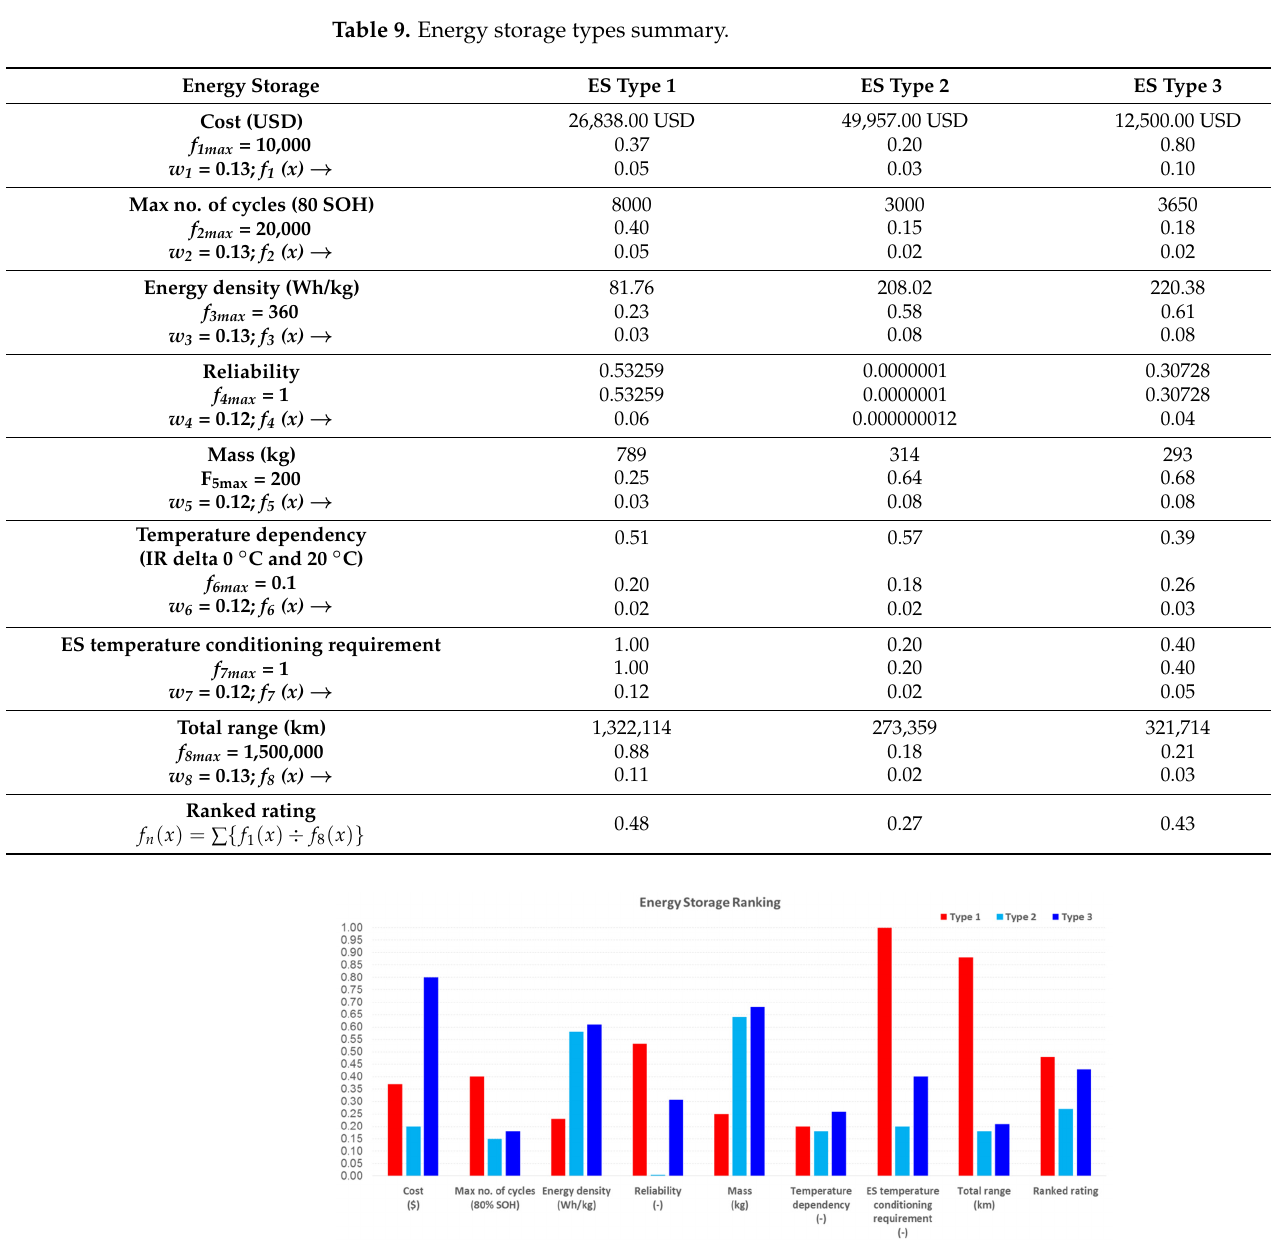
Table 9. Energy storage types summary.